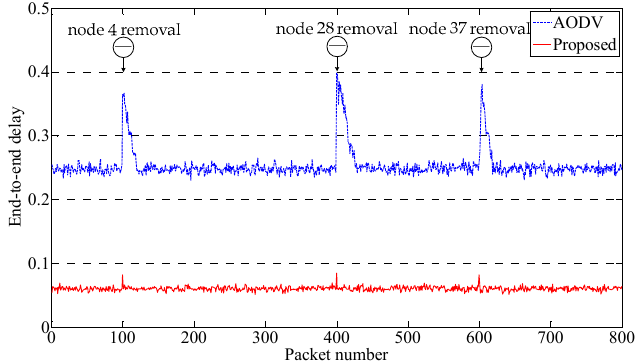
Figure 10. Routing protocol performance with node removal.